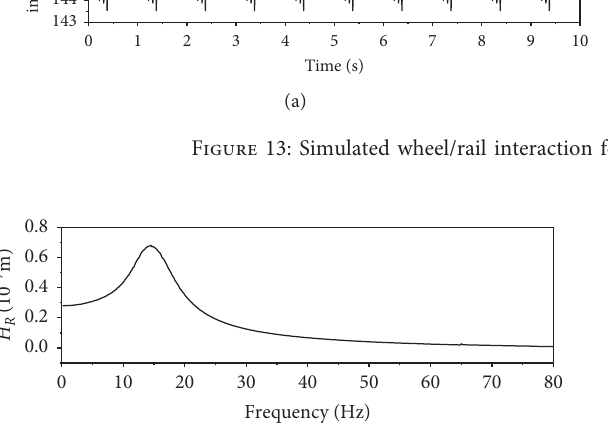
Figure 14: Receptance of track-ground